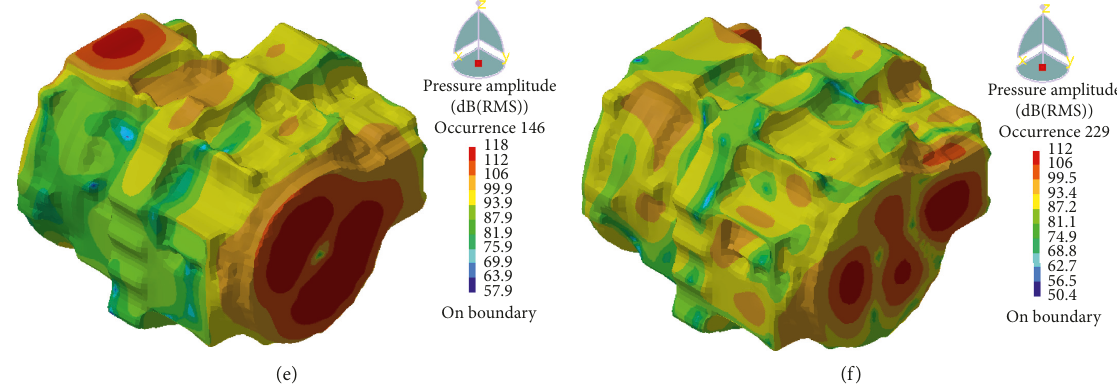
Figure 10: Sound pressure levels of the housing surface. (a) 770Hz. (b) 830Hz. (c) 870Hz. (d) 1010 Hz. (e) 1650Hz. (f) 2480Hz.